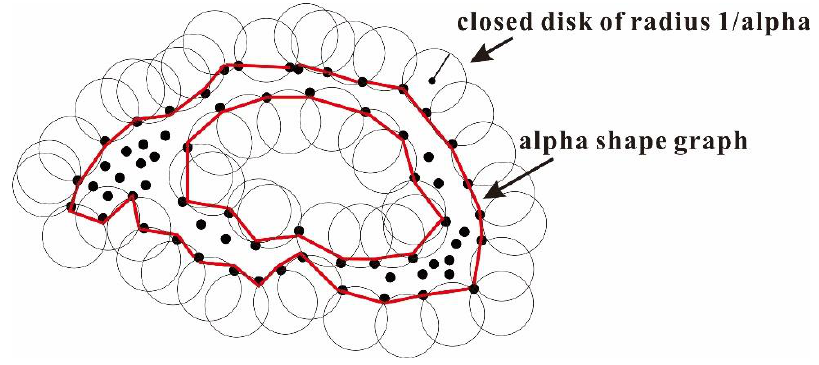
Figure 4. Schematic diagram of alpha shapes algorithm (modified after work in [34]).